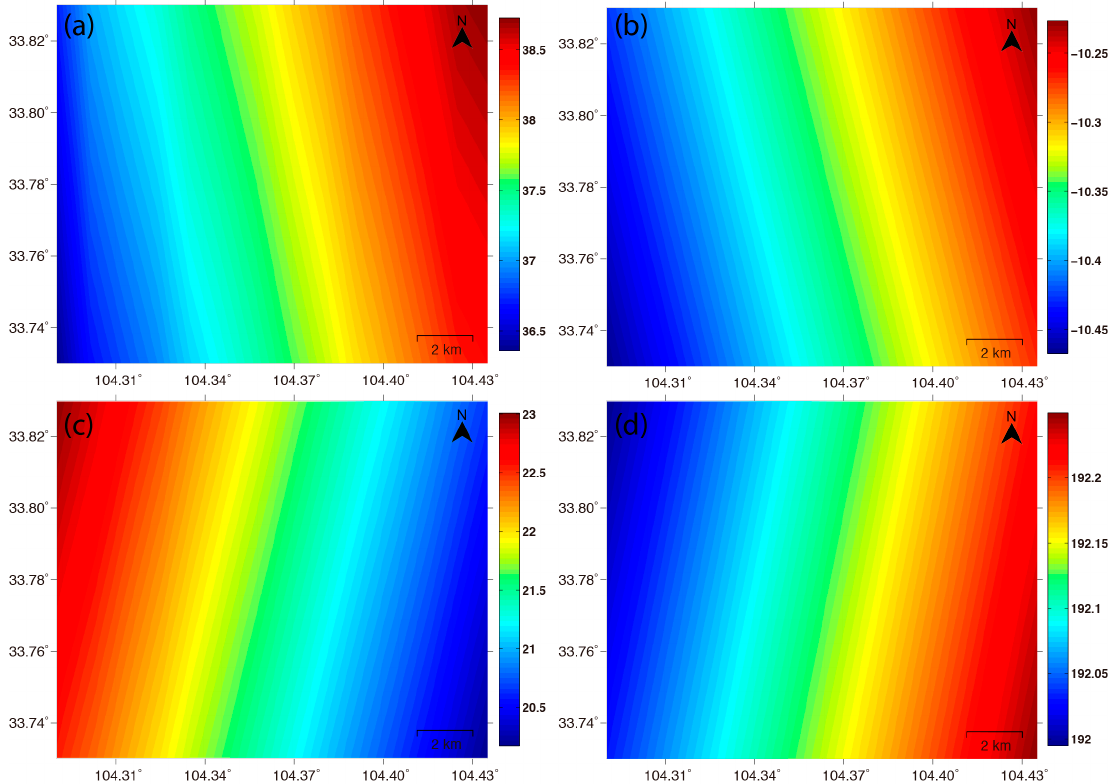
α for the used ALOS ascending α for the used ENVISAT descending